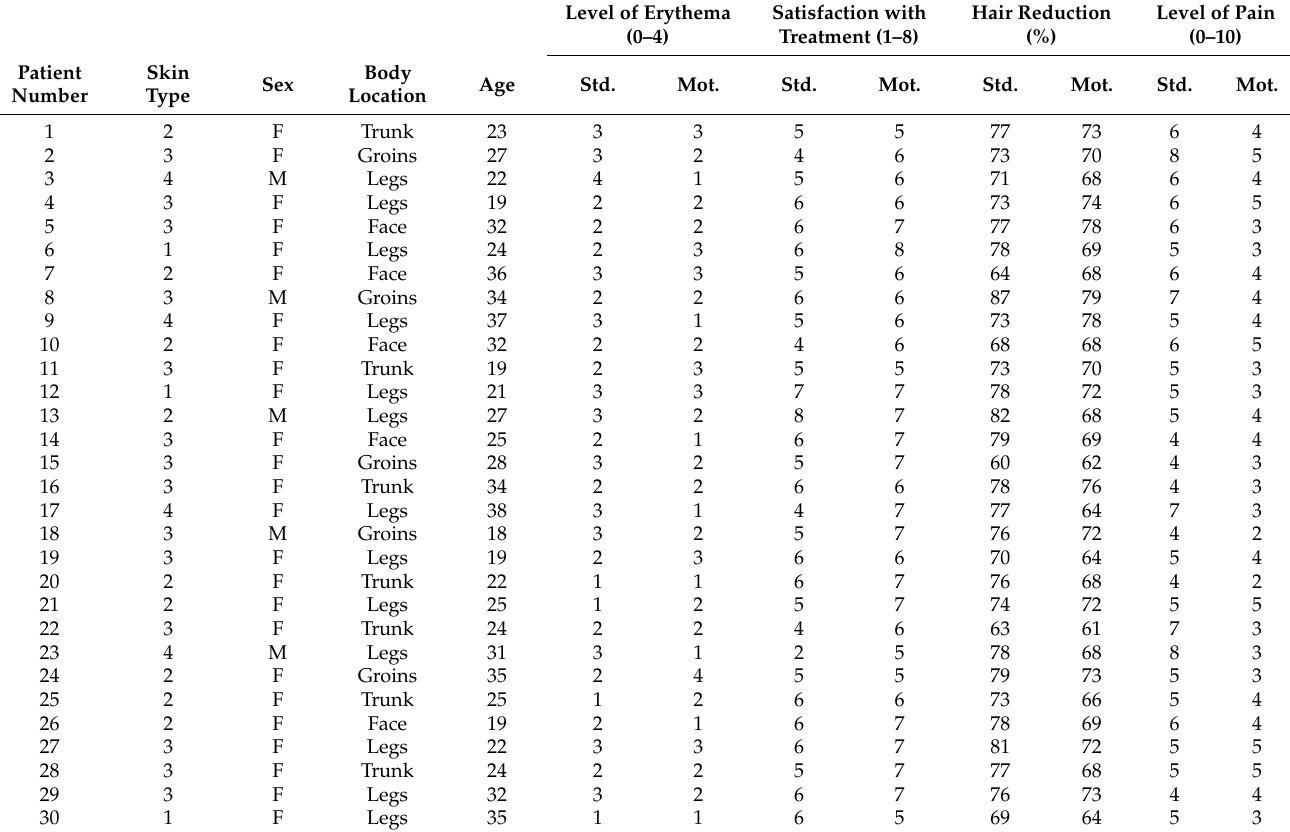
Table 1. Patients’